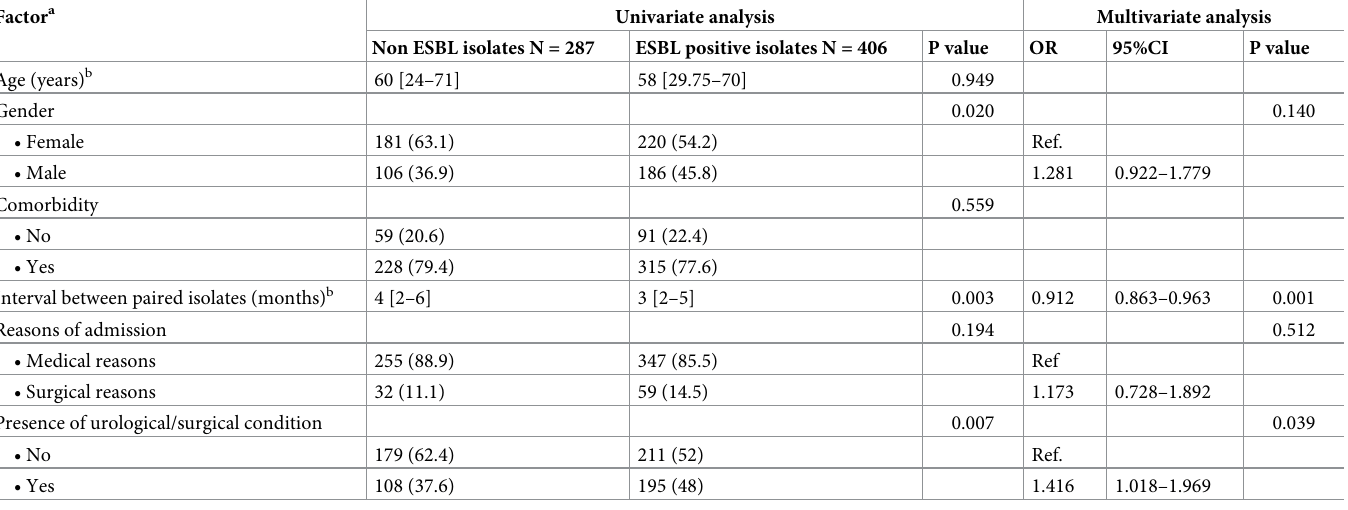
Table 2. Predictors of urine culture identity results of the index episode.